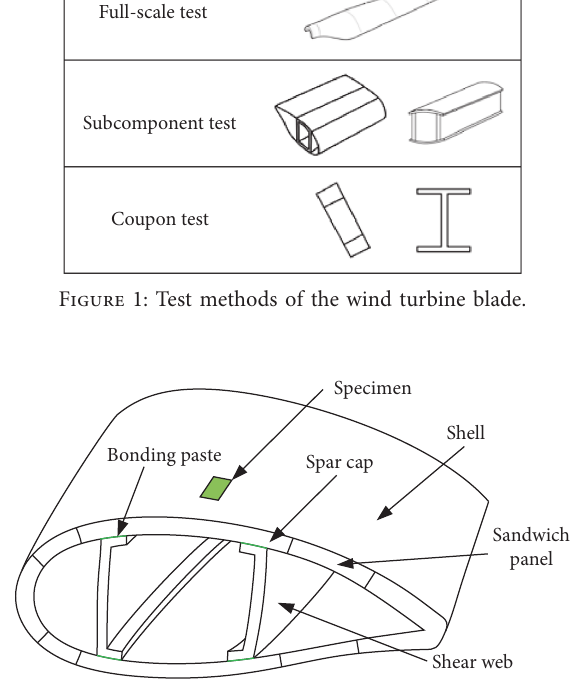
Figure 2: Components of the